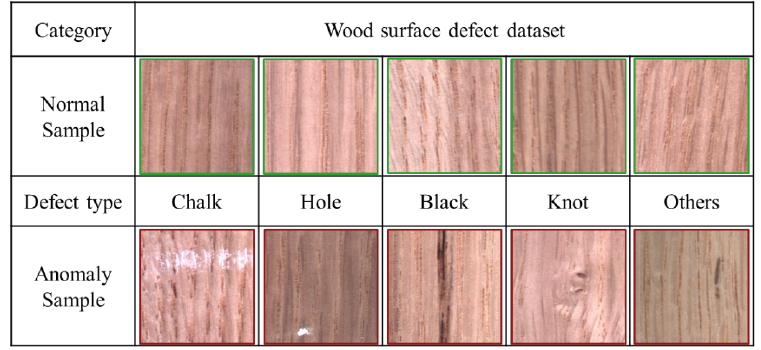
Figure 6. Production line wood surface